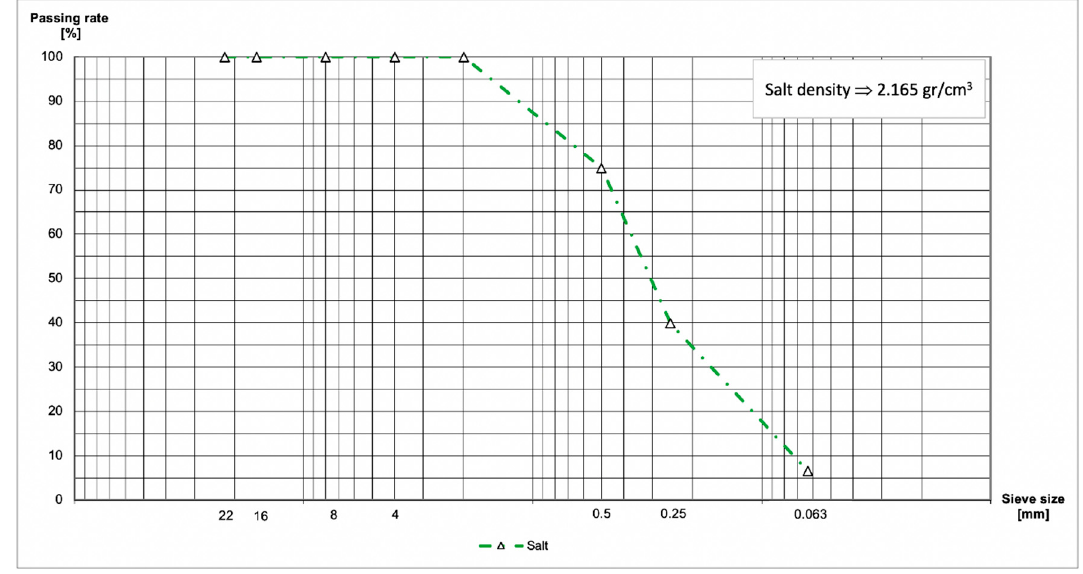
Figure 2. Passing rate and density of salt.